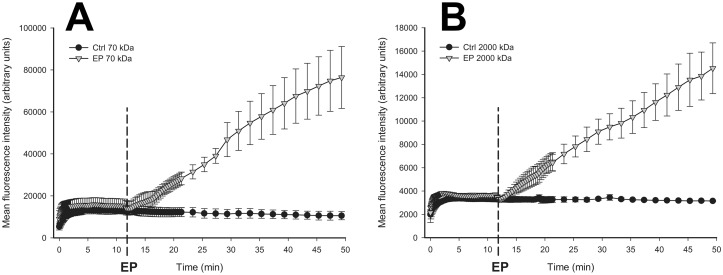
The temporal profile of the mean FD fluorescence intensity in the tissue.The temporal profile of the mean FD fluorescence intensity in the tissue (extravascular compartment) after application of EP for 70 kDa FD (A) and for 2000 kDa FD (B). Data represents mean values from 3 mice. Error bars represent SE. The span of x axis corresponds to Phases II and III form Fig. 1.